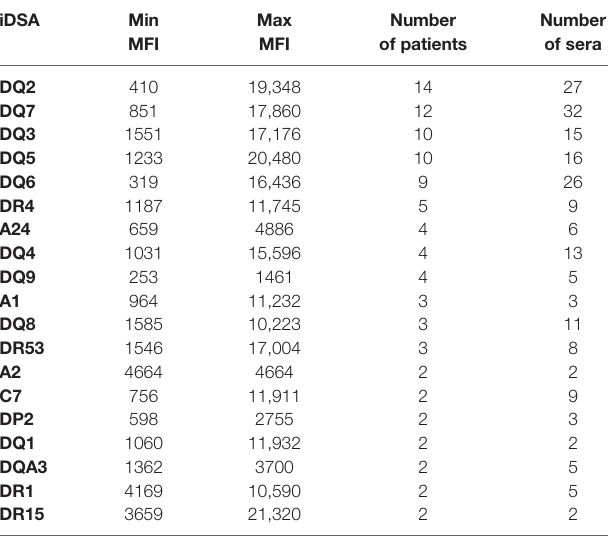
TABLE 2 | Description of immunodominant DSAs identi fi ed in the cohort. iDSA Min